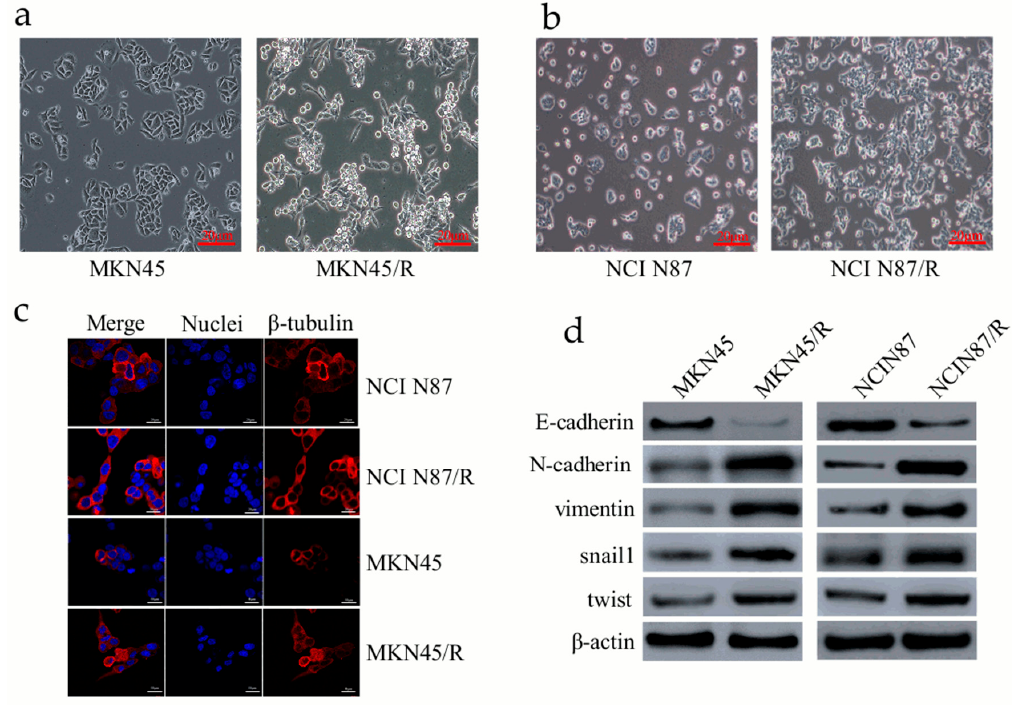
(Figure S1b,c). The resistance index of MKN45/R and NCI N87/R cell lines for trastuzumab